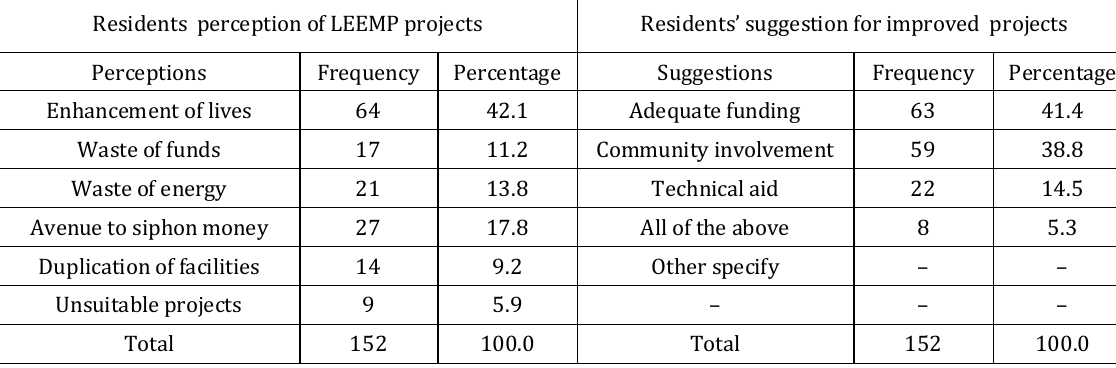
Table 6. Residents perceptions and suggestions for improved performance of the LEEMPs Residents perception of LEEMP